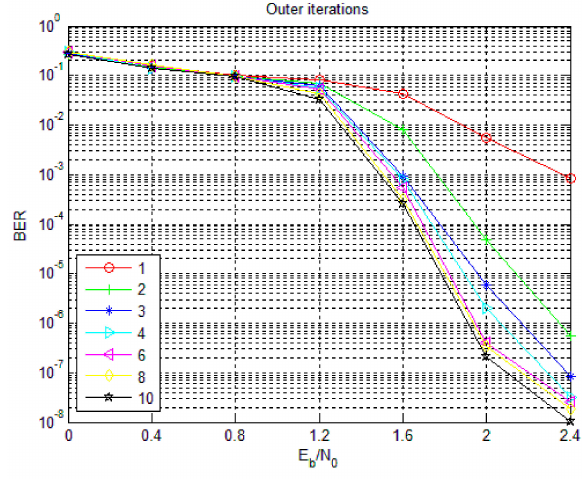
Figure 12. The influence of outer iterations on the performance of 8-ary LDPC-CPM